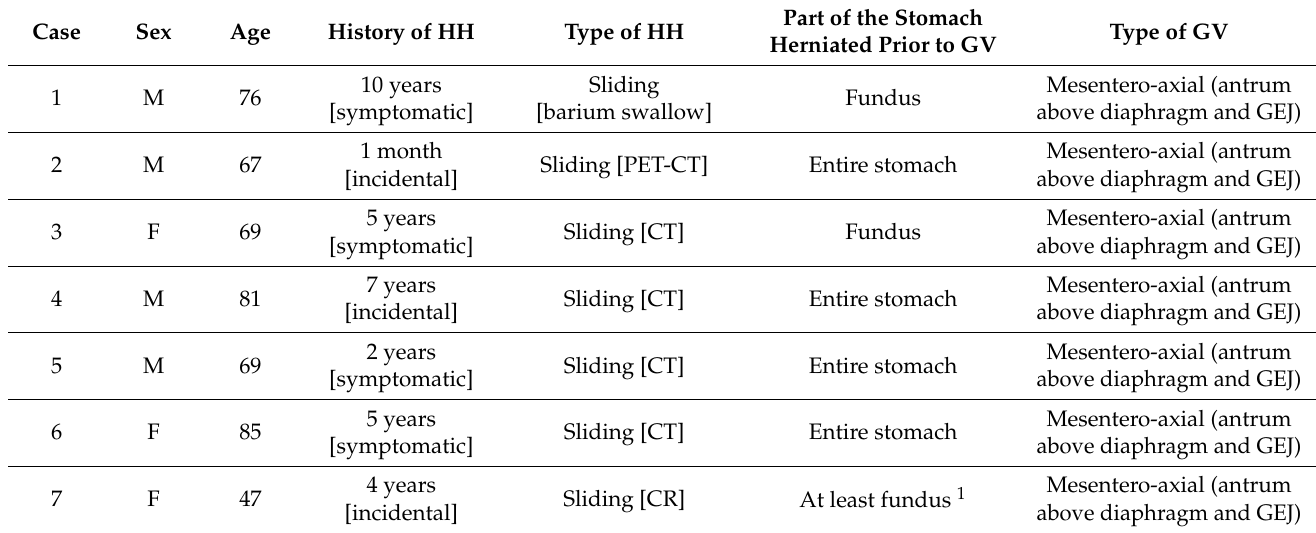
Table 1. Sociodemographic data, hiatal hernia (HH) characteristics and type of acute gastric volvulus (GV). M, male; F, female; (PET-)CT: (positron emission tomography)-computed tomography; BS: bar- ium swallow; CR: conventional radiography; WBC, white blood cell; GEJ, gastroesophageal junction.